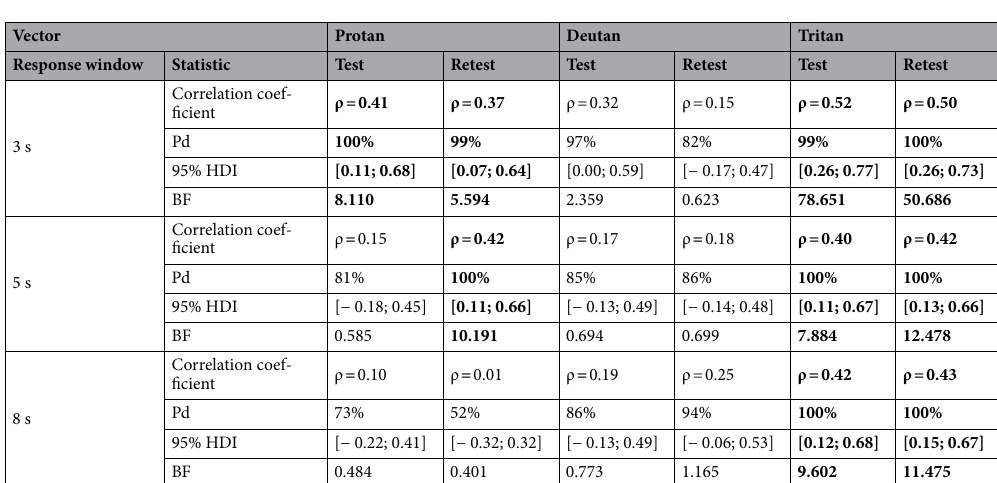
Figure 5. Tritan measures. The figure is organised as Fig. 4.